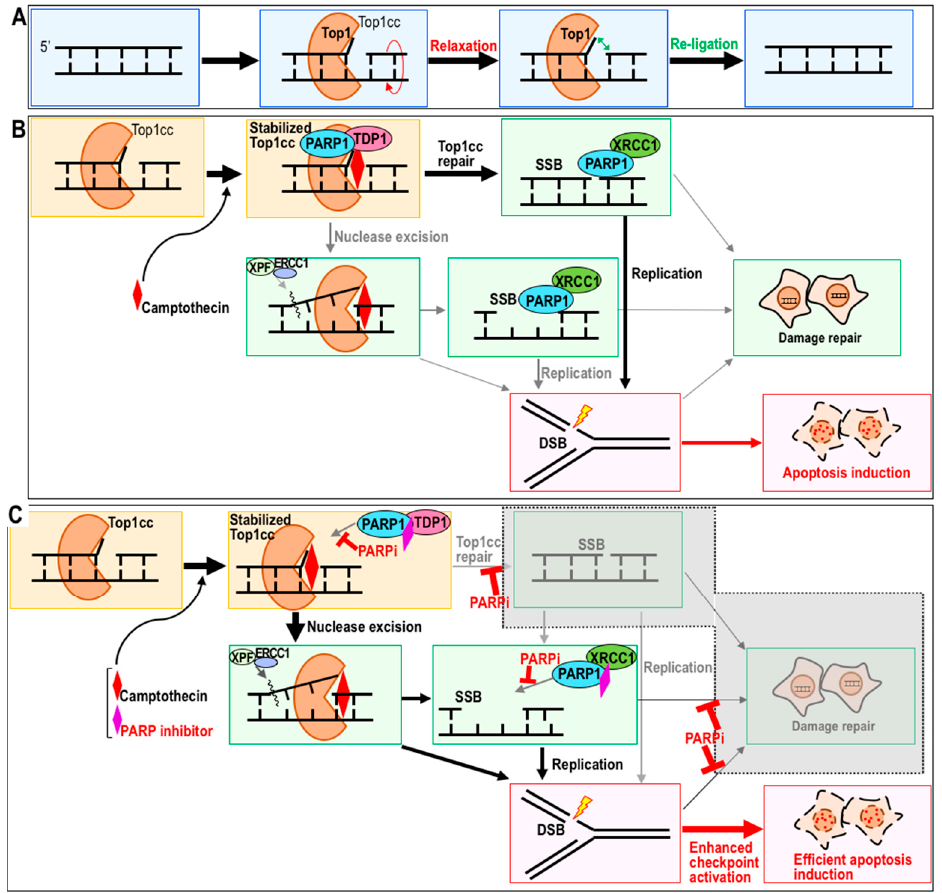
Figure 1. Model of the topoisomerase 1 reaction and its inhibition by camptothecin (CPT) and poly (ADP-ribose) polymerase (PARP) inhibitor. ( A , B ) Top1 cuts a single strand of DNA to relax super-coiled DNA stress ( A ). CPT blocks the ligation step and, hence, induces toxicity during the subsequent S phase in association with replication stress ( B ). ( C ) PARP inhibitor sensitizes the cell to CPT by blocking multiple steps of the repair pathway. In this cellular background, apoptosis is induced more efficiently.